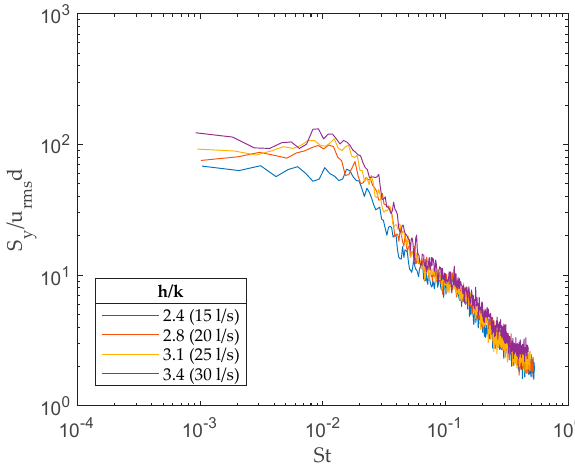
Figure 10. Power density spectra at z = 5 mm for the different runs. The ordinates were made dimensionless by dividing by the local root mean square multiplied by the diameter of the rods.